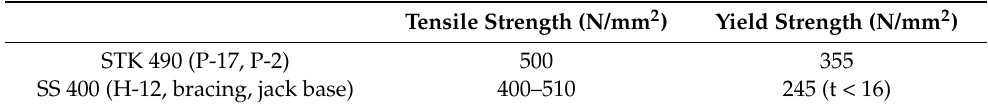
Table 5. Materials data of experimental members.